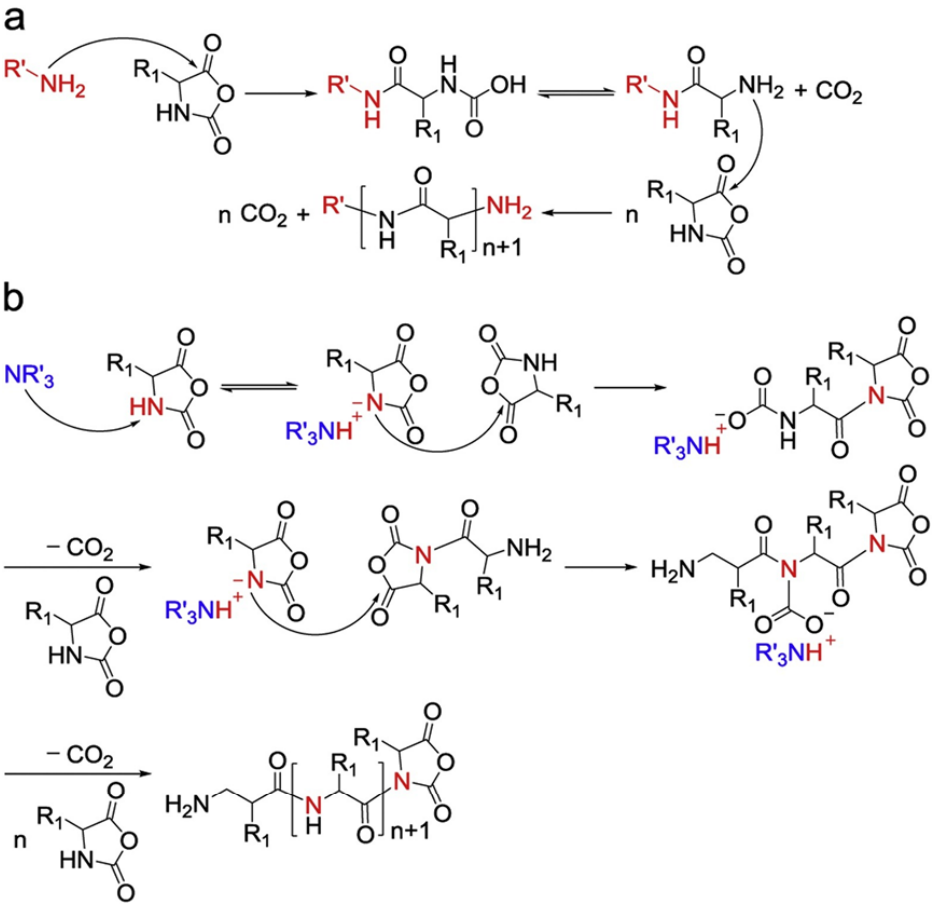
Figure 2. Schematic illustration of polypeptide formation mechanism, (a) normal amine mechanism and (b) active monomer mechanism. Reprinted with permission from Ref. [30]. Copyright: 1997, John Wiley & Sons, Inc.